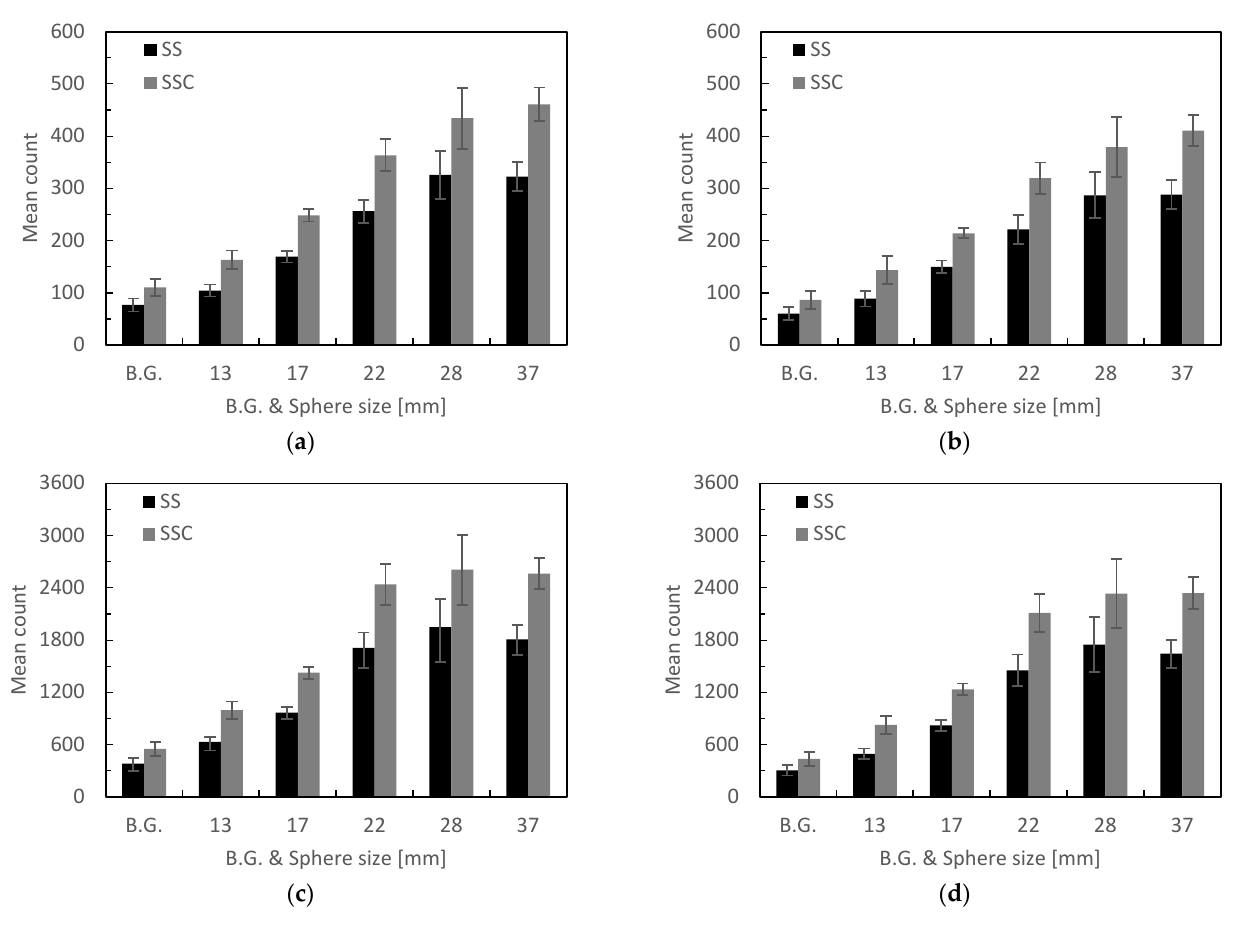
Figure 2. Mean counts per pixel of the background region and each hot sphere for scan modes and quantitative correction methods: ( a ) AC, ( b ) ACSC, ( c ) ACRR, and ( d ) ACSCRR. Table 1. Increased rate of counts for the SSC mode in comparison with the SS mode.